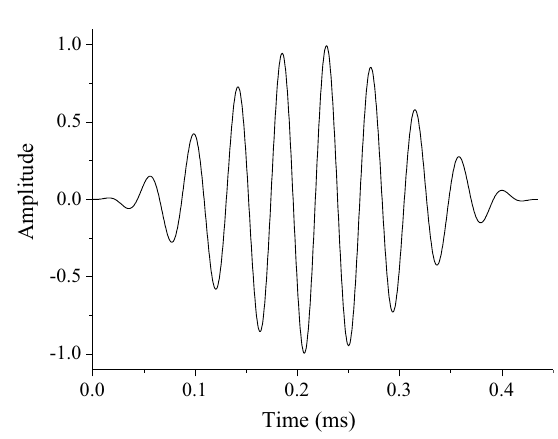
Fig. 10 Excitation signal input for the numerical simulation